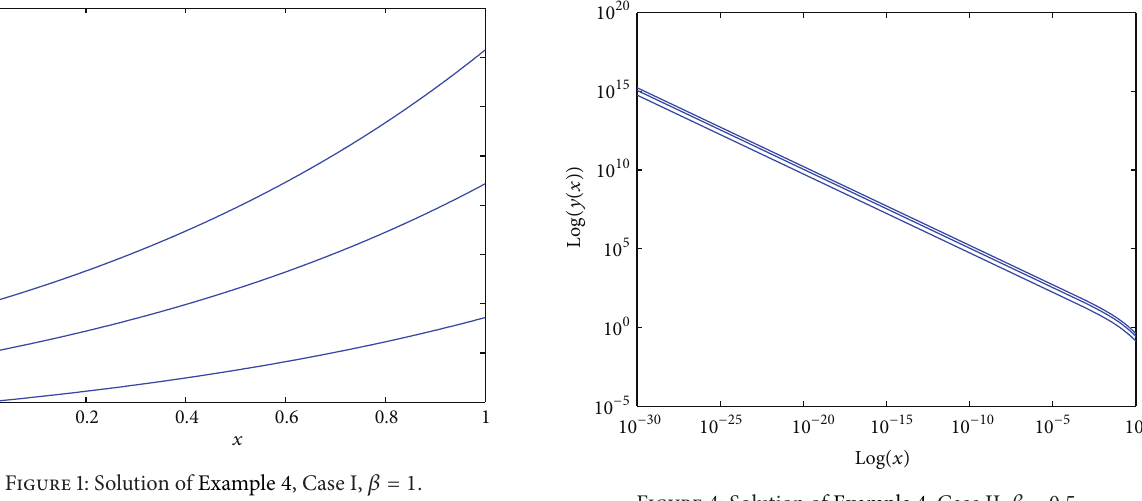
Figure 4: Solution of Example 4, Case II, 𝛽 = 0.5 .